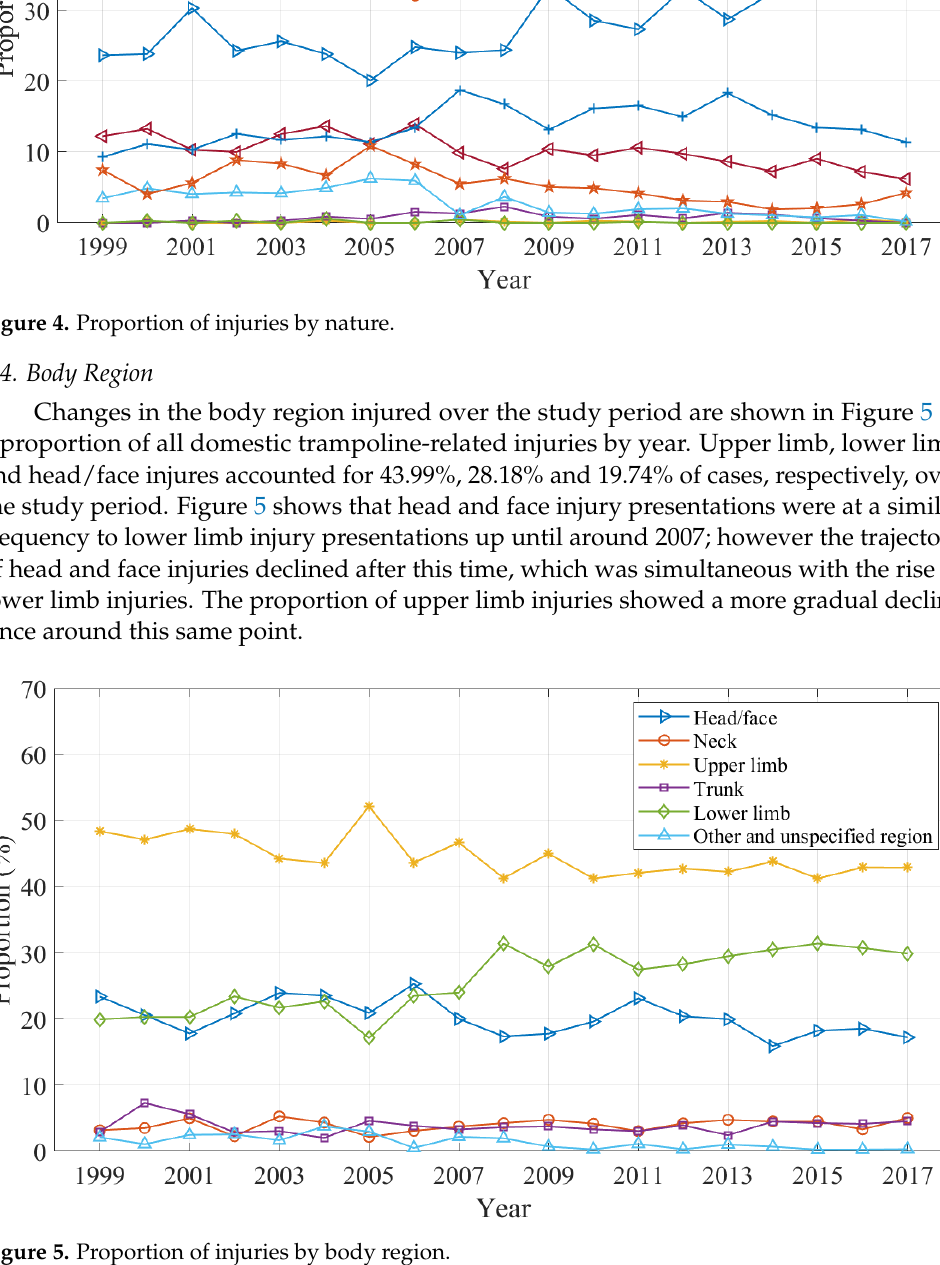
Figure 5. Proportion of injuries by body